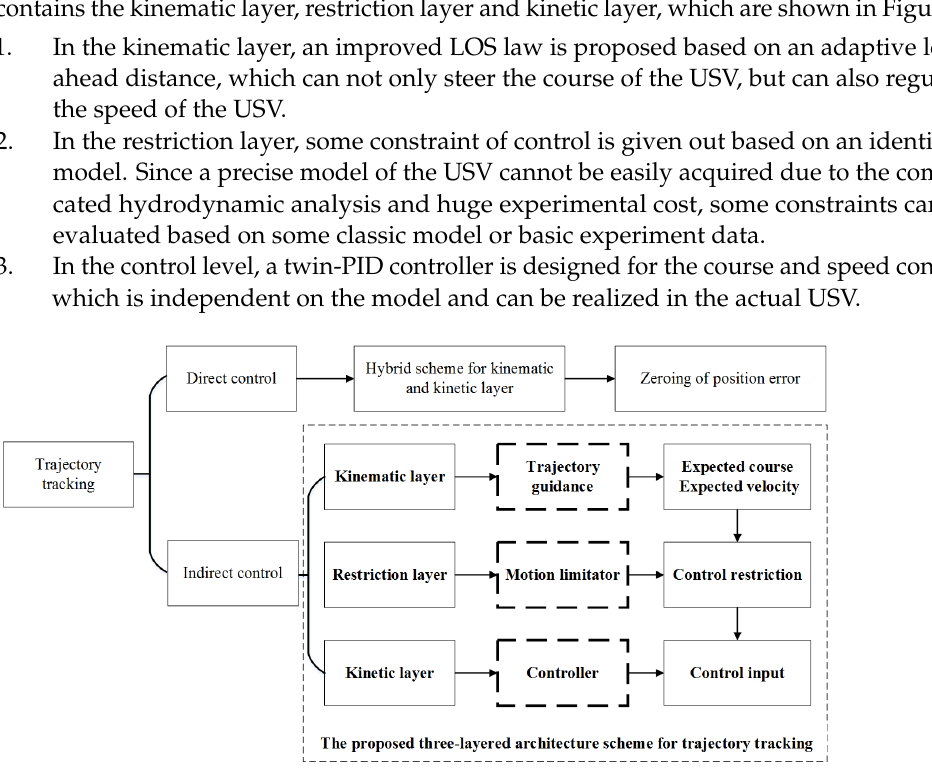
Figure 1. The two categories of the trajectory tracking and the proposed three-layered architecture scheme for trajectory tracking of the USV.